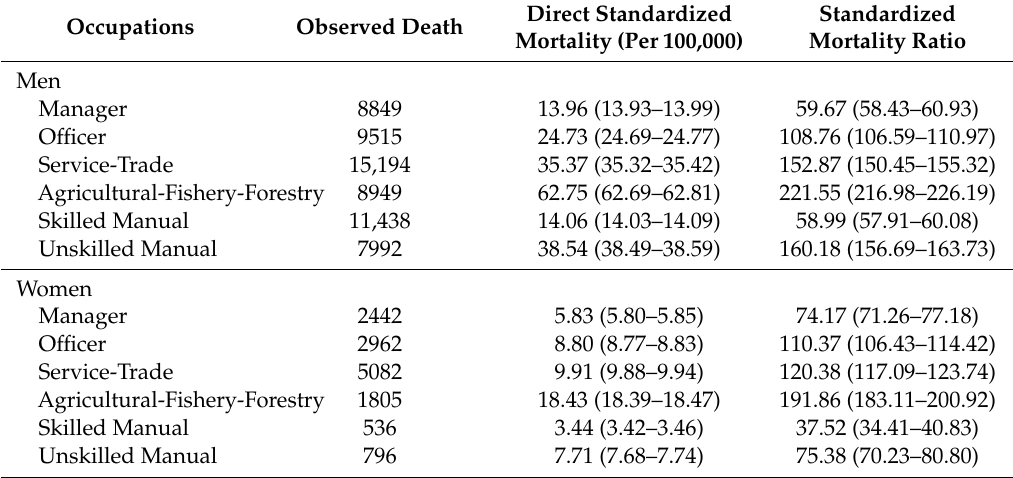
Table 1. Suicide and mortality ratio during